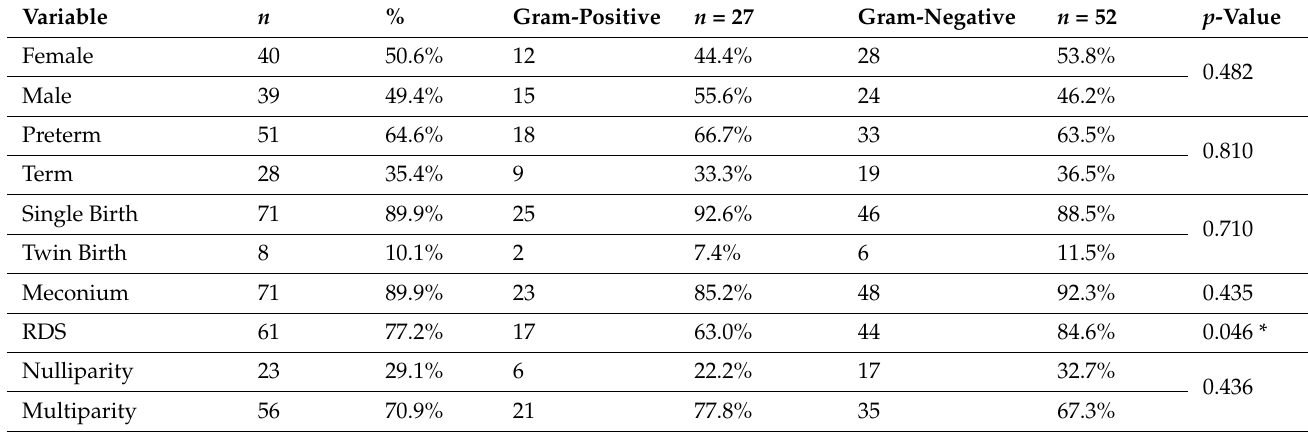
Table 2. Descriptive and univariate analyses of all neonatal HAC samples ( n =